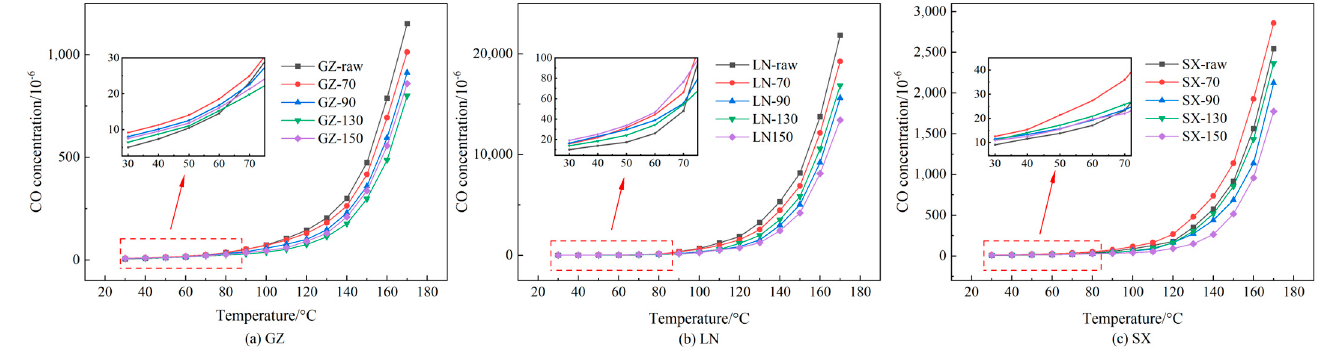
Figure 4. CO concentration at the outlet of the sample reactor: (a) GZ; (b) LN; (c) SX.